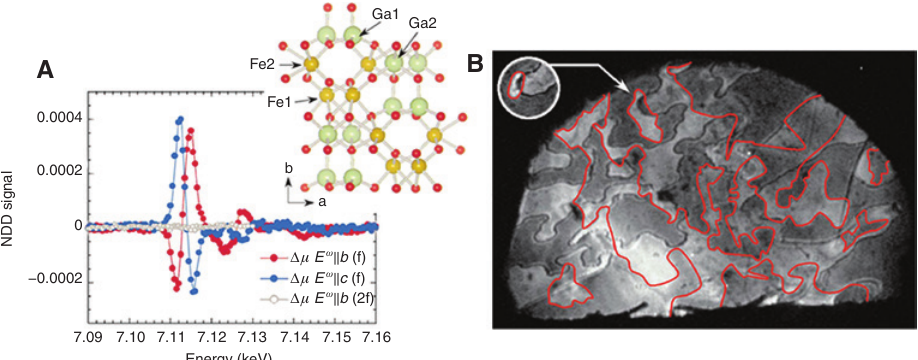
Figure 3: Examples of the interaction between optical waves and toroidal materials. (A) NDD signal measured from a GaFeO crystal for a polarization of the incident X-rays being aligned as E ω || b and E ω || c , where a and b are 3 depicted in the inset [96]. (B) Ferrotoroidic domains of a LiCoPO (100) sample at 10 K imaged with SHG light at 2.197 eV [78]. Black and red 4 lines indicate the different ferrotoroidic domain walls caused by T and T , respectively. Inset: ferrotoroidic domain movement caused by a z y temperature cycle. Figures reprinted with permission from (A) Ref. [96], APS; (B) Ref. [78],